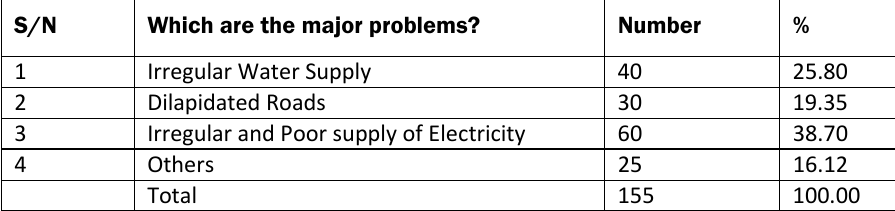
TABLE 2: Citizens’ opinions regarding major problems confronting them in the city S/N Which are the major problems?